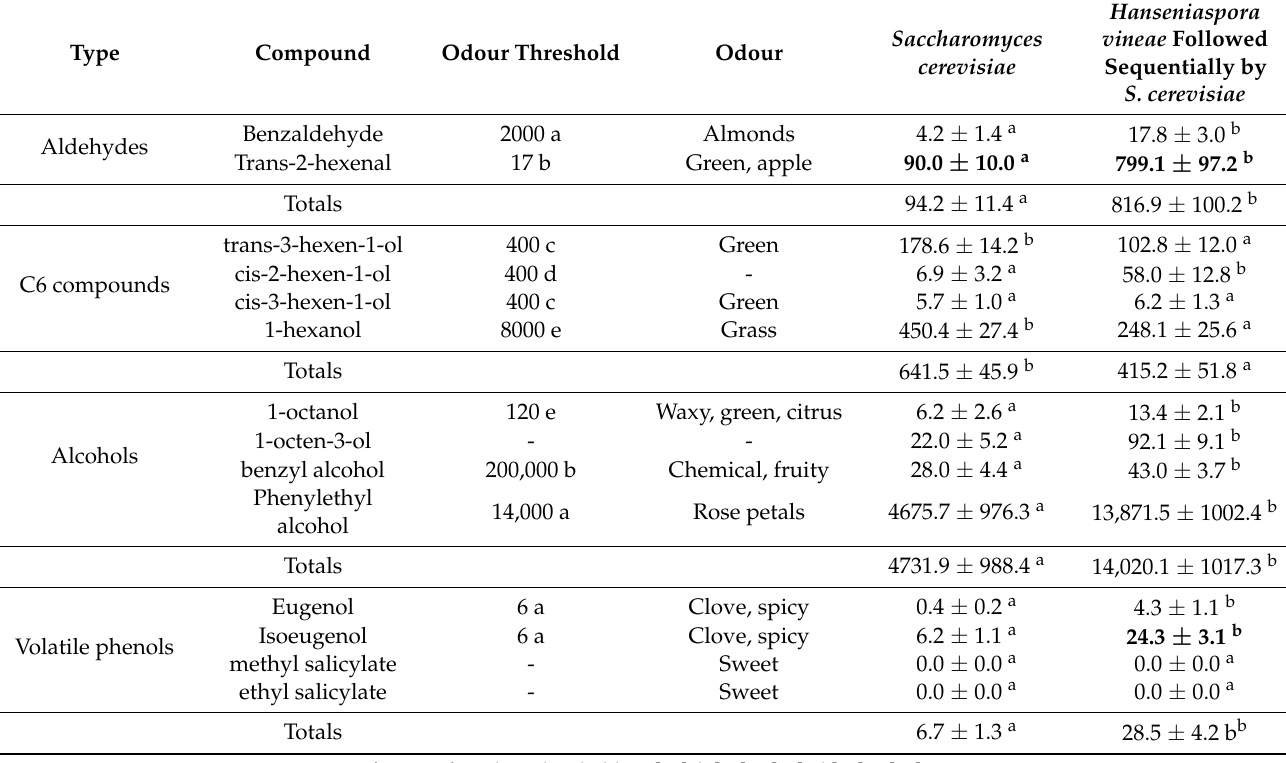
Table 2. Concentrations of aldehydes, C6 compounds, alcohols and volatile phenols ( µ g/L) in wines fermented by Saccharomyces cerevisiae by Hanseniaspora vineae followed sequentially by S. cerevisiae . Values are means ± standard deviations ( n = 3). A different letter in the same row means significant differences ( p < 0.05). Values in bold type are those with high differences and above the odour threshold in